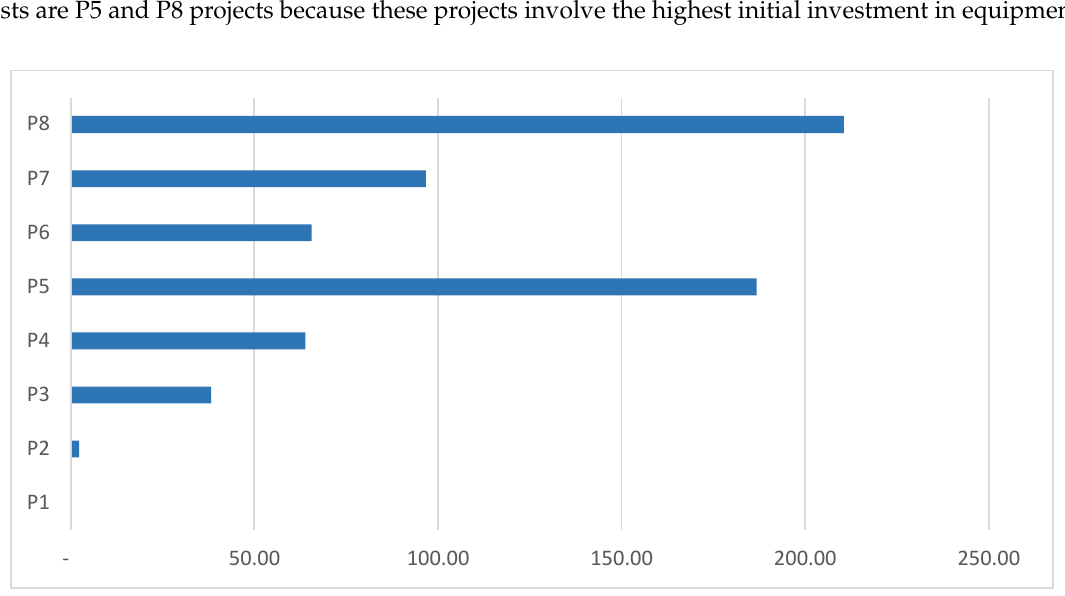
Figure 6. The removal and final disposal costs in euro/m 2 for implementing each type of project. Table 4 shows the areas rehabilitated annually in each scenario for each county of the South- Muntenia region. The calculations were based on data from the National Institute of Statistics on the surface of the dwellings in the South-Muntenia region. At the regional level, in each of the three scenarios considered, the counties Arges, Dâmboviţa and Prahova hold the most important shares of the existing surface of the existing dwellings. In the minimal scenario, energy efficiency projects will include nearly one-third of the surface area of dwellings by 2050, and in the maximum scenario, energy efficiency projects will cover the entire surface of dwellings by 2050.